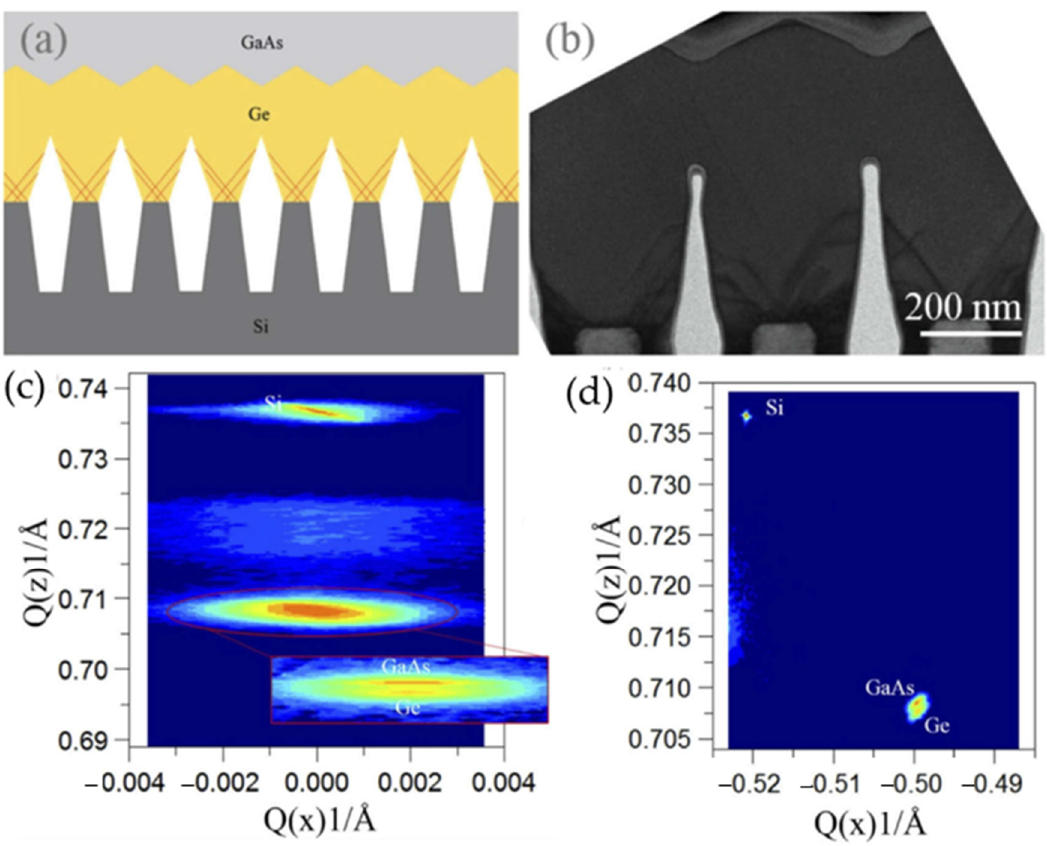
Figure 19. ( a ) The schematic illustration of the GaAs grown on the Ge / Si hollow substrate. It also shows the dislocation termination at the sidewalls. ( b ) Cross-sectional TEM image of 600 nm-thick Ge layer grown on the hollow patterned (001) Si. High-resolution XRD reciprocal-space mapping around ( c ) (004) and ( d ) (2( − )2( − )4). Inset of ( c ) Higher resolution (004) map from triple-axis mode. Reprinted with permission from Reference [243] © 2020 The Optical